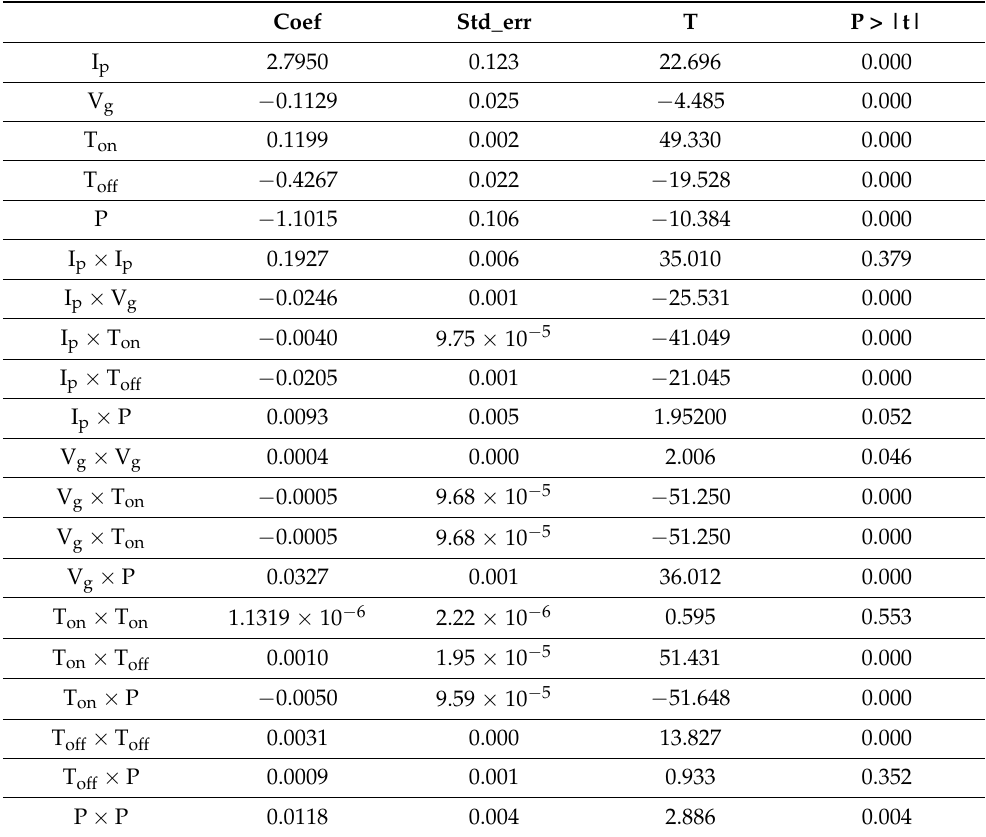
Figure 15. Heat map for change in OOR. Table 6. Coefficients and probability for change in